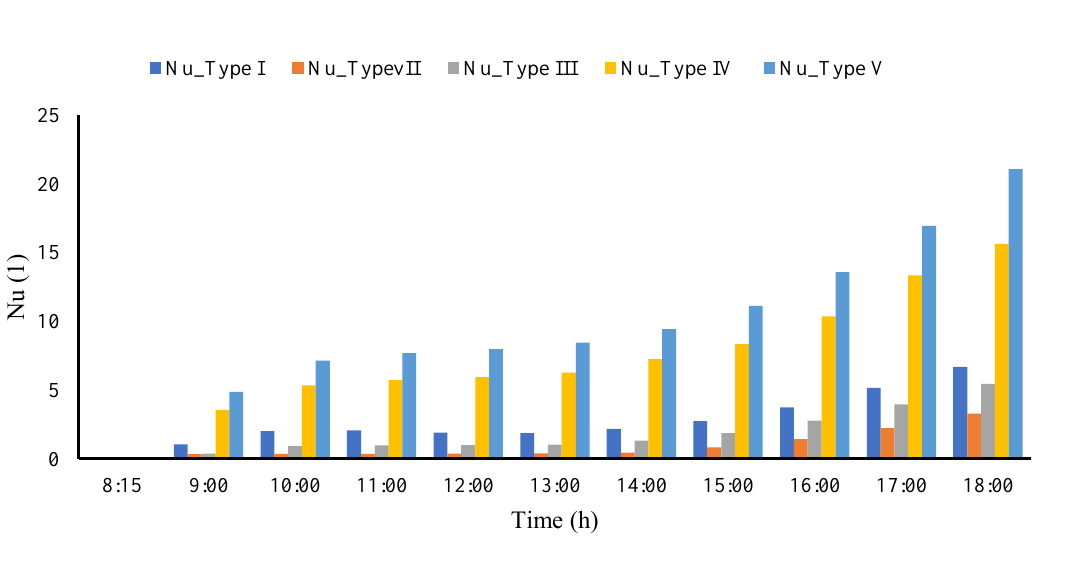
Figure 9. Heat transfer coefficients with various locations of absorber plates Nusselt number distributions strongly depend on the absorbing plates' geometry and location. The optimal configuration allows the airflow to follow the absorbing surfaces' trajectory and contact them on both sides. There are five absorber plate locations among the absorber Types shown in Figure 10. Due to the increasing amount of area and air over the top and bottom, surface heat is removed from the heated absorber plate and transferred to the fluid.